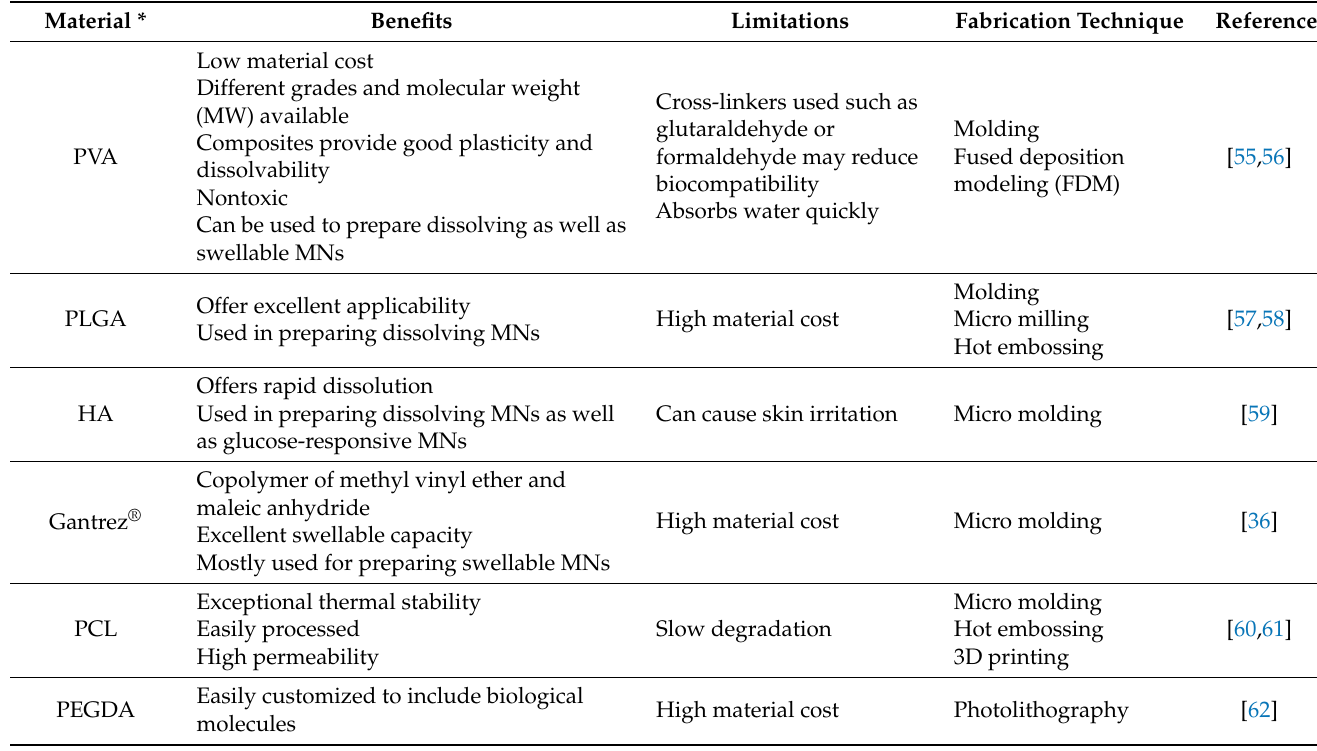
Table 1. General properties of typical polymers used in the preparation of